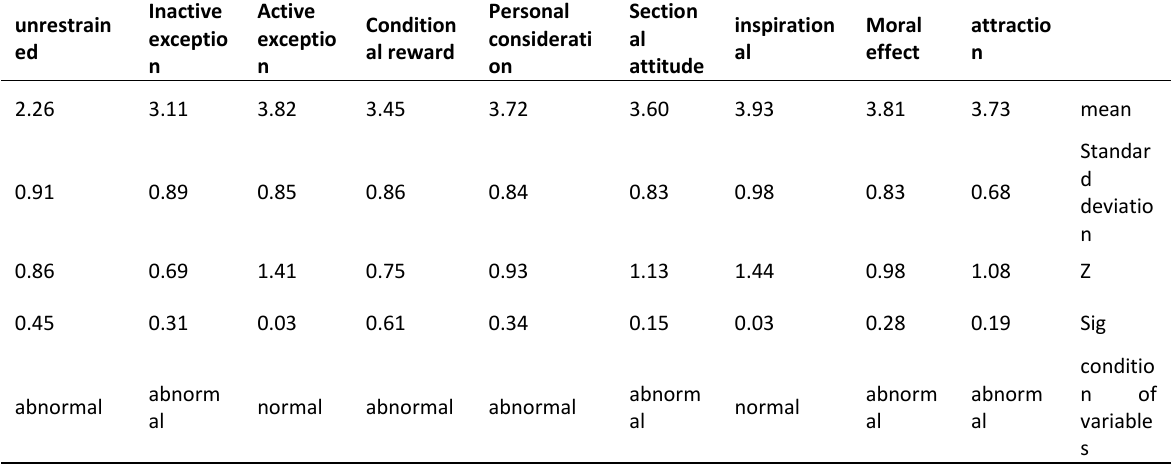
Table 3. Results of Kolmogorov-Smirnov test on leadership style and its components